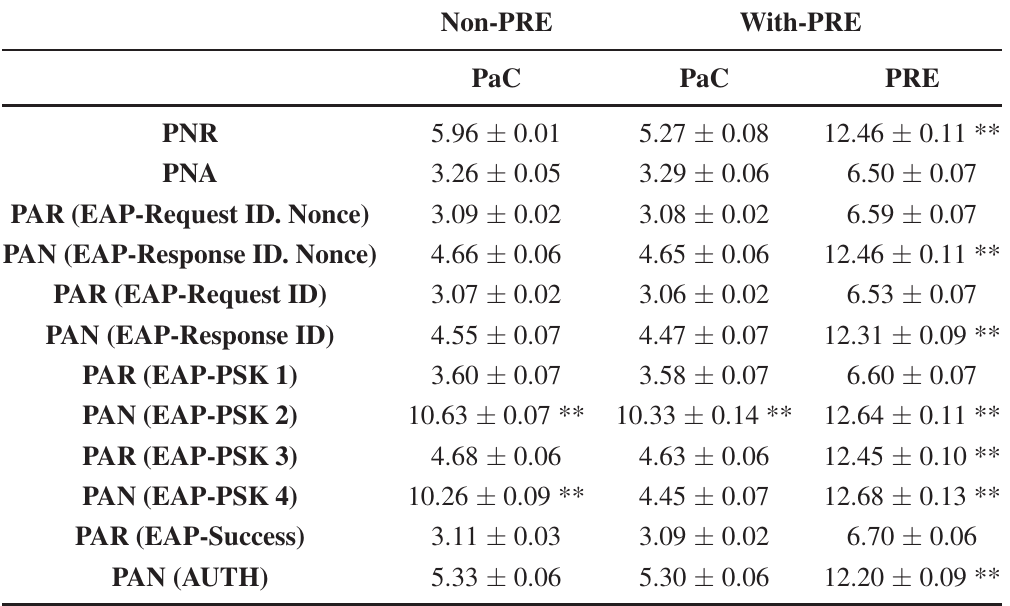
Table 4. Re-authentication mean processing time (ticks) per